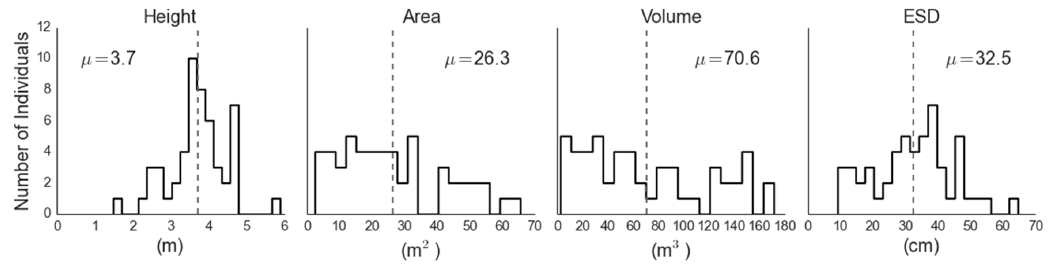
Figure 5. Distributions of juniper canopy parameters retrieved via ground measurement.